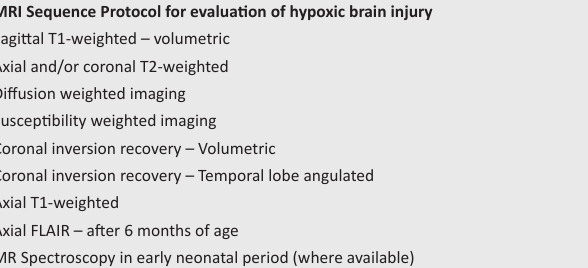
TABLE 2: List of magnetic resonance imaging sequences in the scanning protocol at the principal author’s